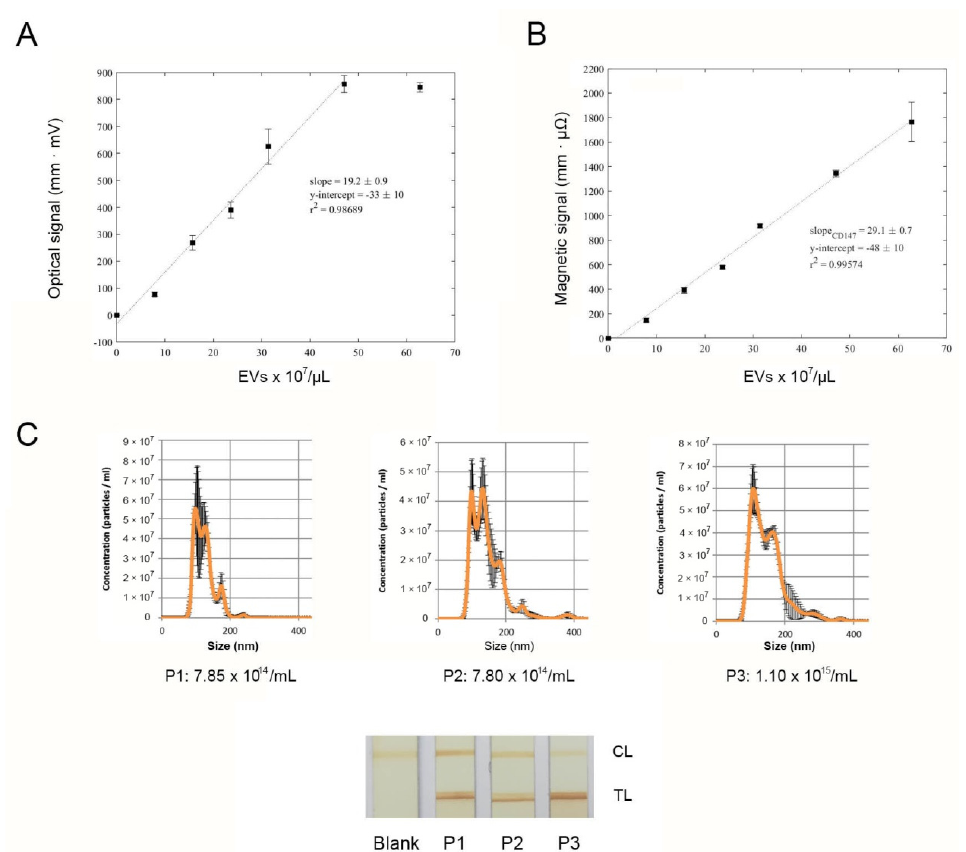
Figure 4. Optical ( A ) and magnetic ( B ) signal intensities obtained in a range of EV concentrations, using anti-CD9 as capture antibody and MNP-anti-CD147 as detection probe. ( C ) Analysis of isolated EVs from three CRC patients. Size and concentration were determined by NTA and CD147 + EVs were detected by LFIA; tests were run in triplicates and the representative immunostrip tests obtained are shown.